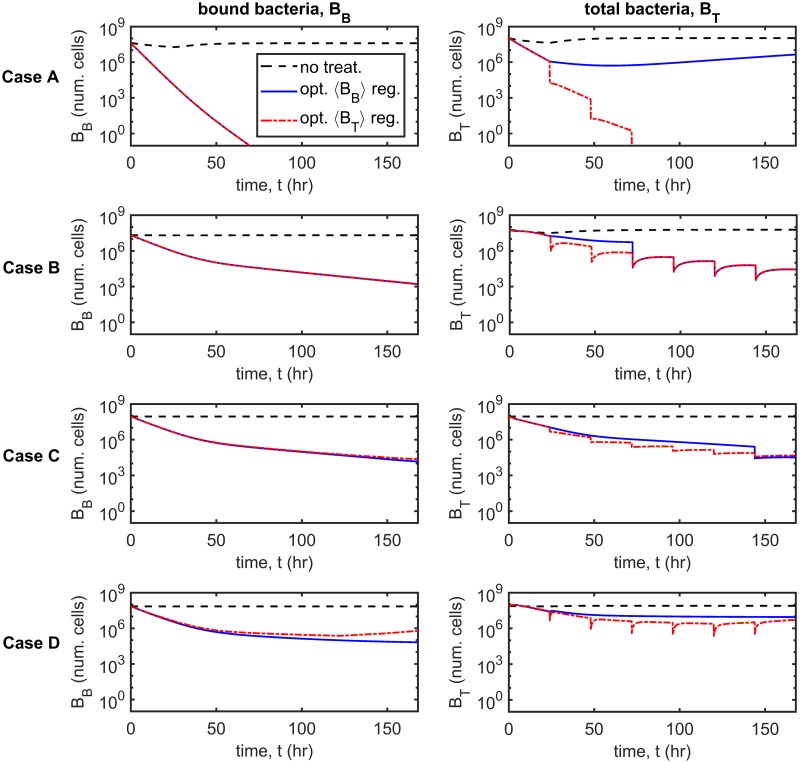
Optimum treatment outcomes—minimising mean bacterial burdens with an established infection.Graphs show the dynamics of the bound and total bacterial burdens, BB and BT respectively (columns), in the untreated case and under the optimal treatment regimens (see Fig 14) for each parameter set (rows). Note the log10 scale on the y-axis. The bacterial burden is eliminated (BT(168) < 1) under the 〈BT〉 optimal treatment regimen in Case A, wile BT(168) = O(106) under the 〈BB〉 regimen. Both regimens achieve BT(168) = O(104) in Cases B and C, and BT(168) = O(106) in Case D. There is little difference in the effects of the optimum regimens under the different optimality conditions for Cases B–D. Eqs 1–11 were solved using ode15s, with a constant antibiotic dose. Parameter values: A = 8 μg ml−1, λ = 0 cm3cell−1hr−1, ρ = 0 hr−1 and ω = 1. The initial conditions are the untreated steady-states for each parameter set, modified so that 2% of the free and bound bacteria are resistant. See Tables 2–4 for the remaining parameter values.